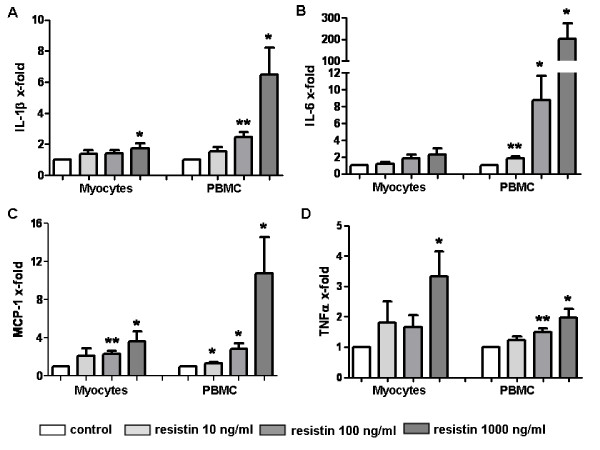
Effects of resistin on inflammatory response in myocytes and peripheral blood mononuclear cells (PBMC). Expression of IL-1α (a), IL-6 (b), MCP-1 (c) and TNFα (d) mRNA levels after stimulation with human resistin (10, 100, 1,000 ng/ml) for six hours in myocytes and PBMC. Data are shown as fold changes compared to unstimulated controls (in graphs represented by control bar, rated as 1). Bars represent the mean + SEM. P-values less than 0.05 were considered statistically significant; * P < 0.05, ** P < 0.01.